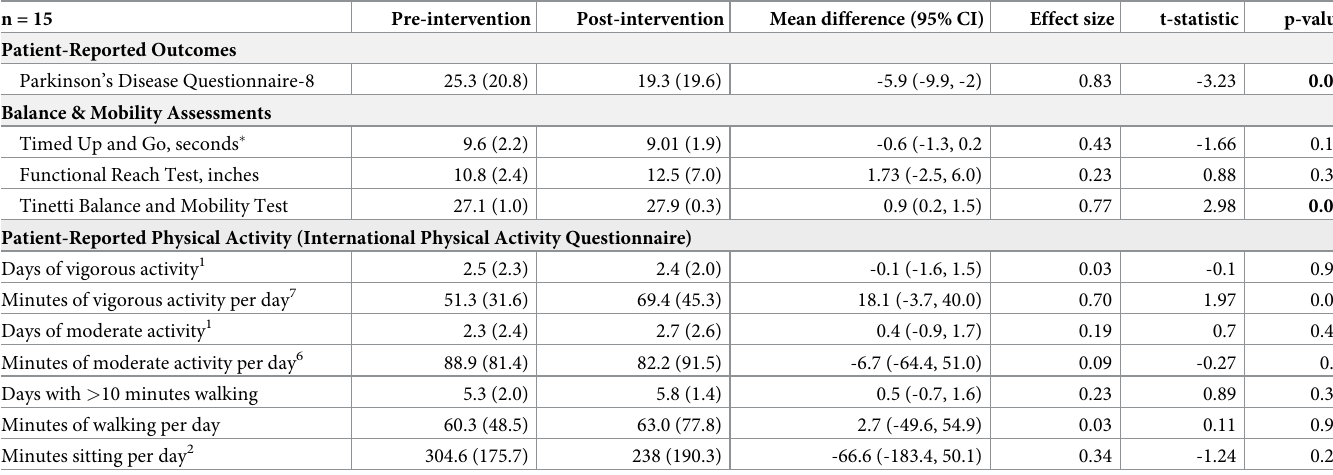
Table 2. Pre- and post-karate secondary outcomes among